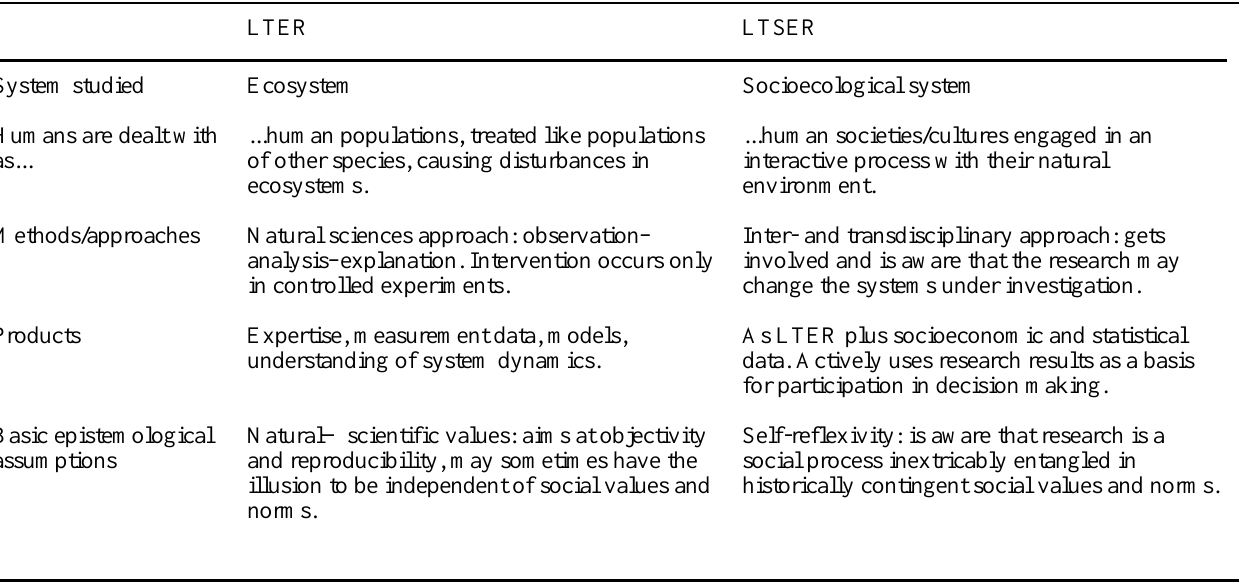
Table 1. Comparison of key features of LTER and LTSER. LTER LTSER System studied Ecosystem Socioecological system Humans are dealt with ...human populations, treated like populations as... of other species, causing disturbances in